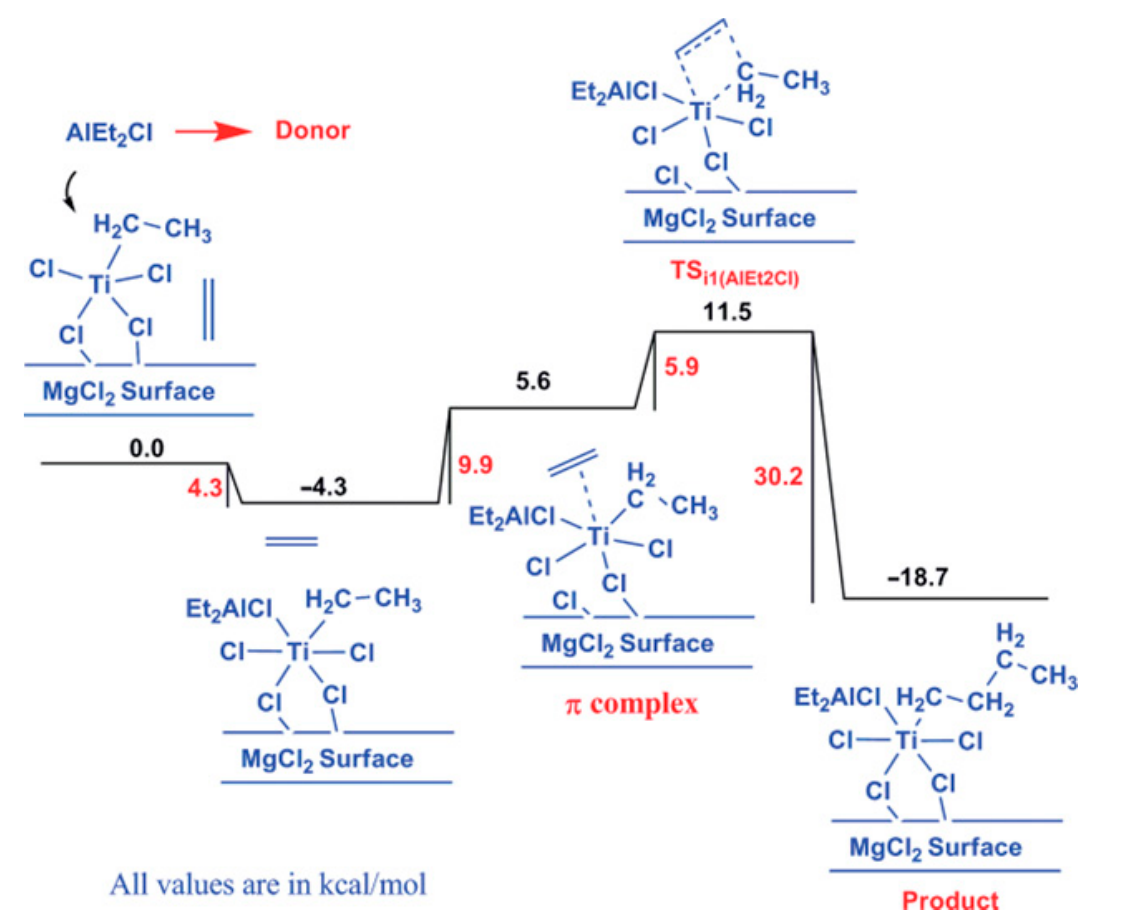
Figure 7. The free energy profile for the insertion of ethylene into the Ti–CH 2 CH 3 chain with an AlClEt 2 group coordinated to the Ti center. Reprinted with permission from [102]. Copyright (2014) American Chemical Society.